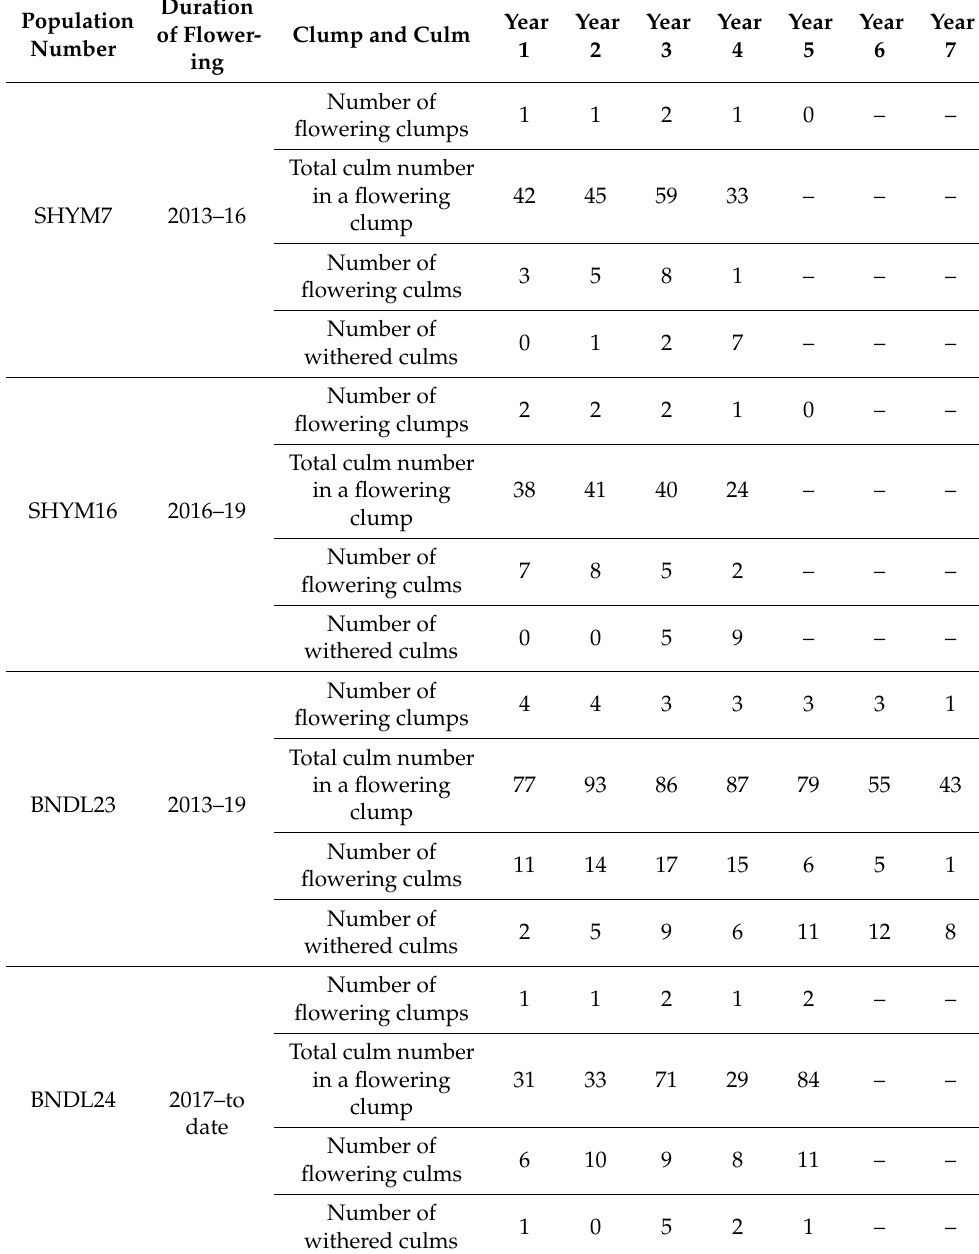
Table 1. Comparison between numbers of flowering vs. non-flowering clump and culm observed for seven years in four populations of B. tulda studied. Absence of flowering was indicated by